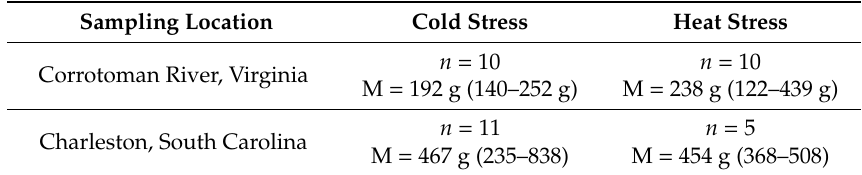
Table 1. Number and weight of spotted seatrout used in the study. M = mean (and range) body mass in